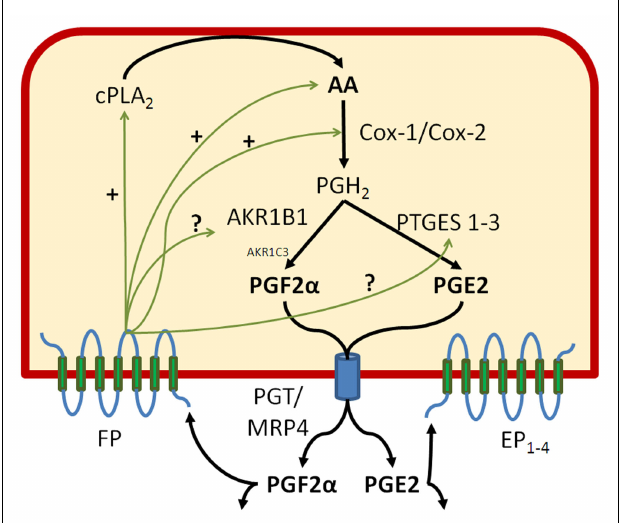
FIGURE 1 | Prostaglandin F2 α and E2 biosynthetic pathways. In order to generate PGF2 α , AKR1B1 must team up with other constitutive and inducible enzymes involved in the production of PGH2, the common precursor of all PGs. Among those, we have found that cPLA2 liberating AA from membrane phospholipids, COX-2, AKR1B1, and mPGES-1 are inducible by the cytokine IL-1 β . AKR1B1 apparently works with both COX-1 and COX-2 producing PGH2 to generate PGF2 α whereas mPGES-1 preferentially associates with COX-2 to generate PGE2. Both epithelial and stromal cells exhibit PGF2 α responsiveness and stimulation or inhibition of the FP receptor alters the production of both PGE2 and PGF2 α through action at several steps of the PG biosynthesis cascade.We also present in this figure the PG transporters PGT also known as solute carrier SLCOA1 and MRP4 the multidrug resistance protein 4 or